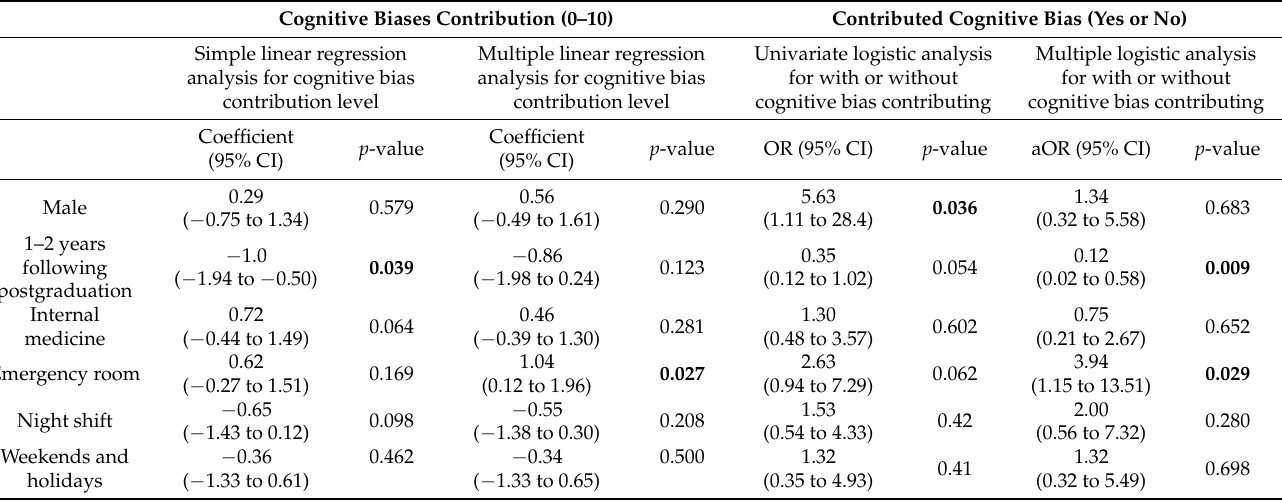
Table 6. Contribution to cognitive bias based on univariate and multivariate